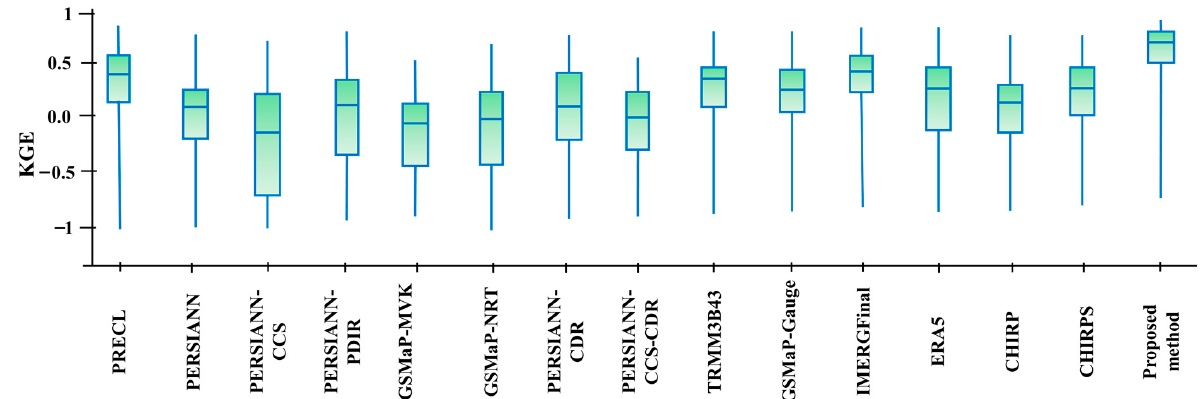
Figure 7. Boxplot of KGE values for the study area within 2003–2021 obtained from point to pixel assessment strategy.